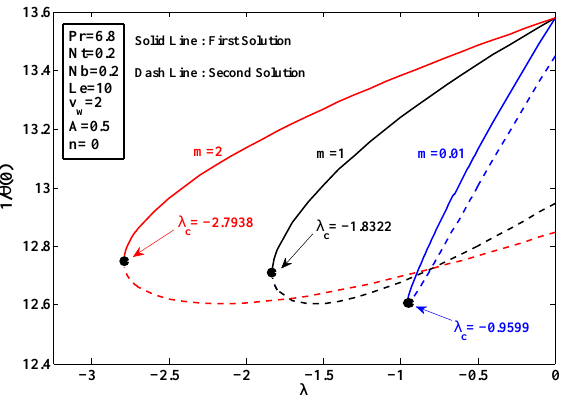
Figure 3: Variation of 1/ θ (0) with the shrinking parameter λ for different values of first-order slip parameter m